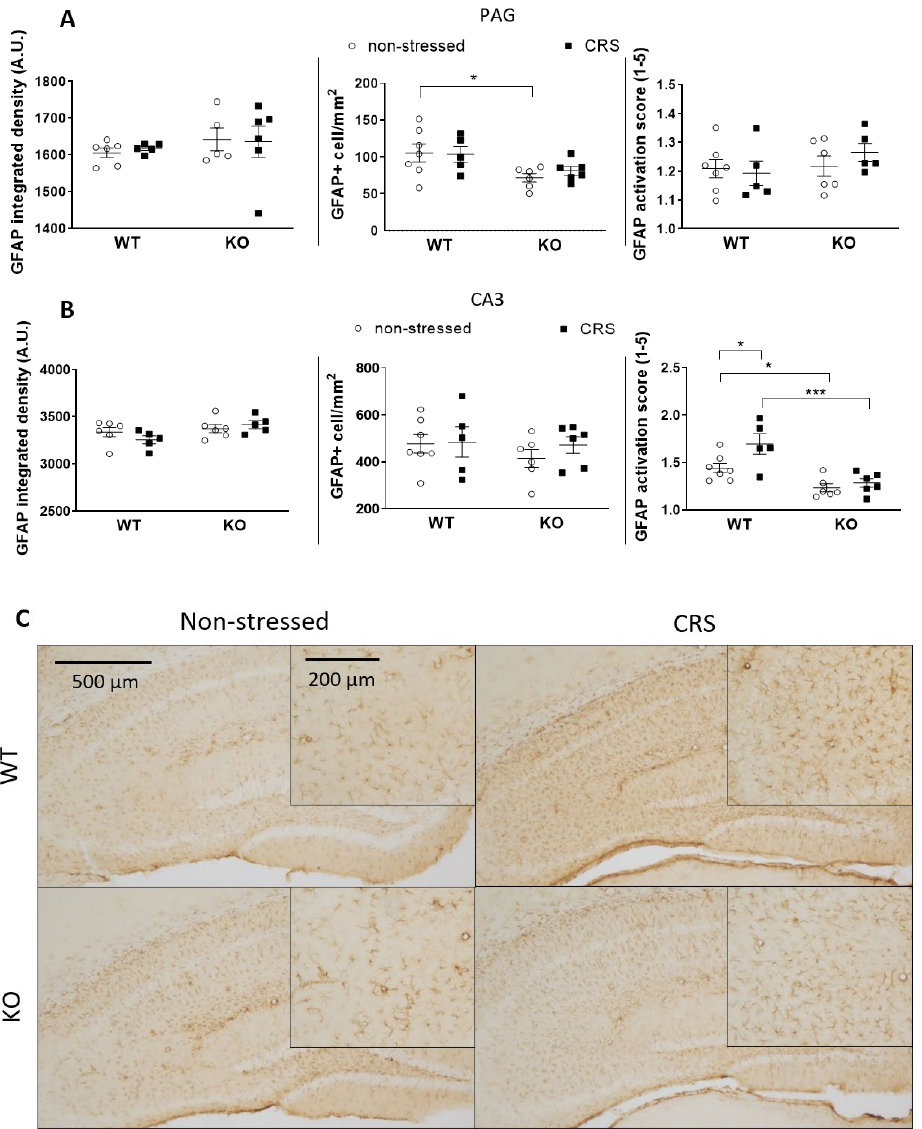
Figure 11. Diagrams show the Glial fibrillary acidic protein (GFAP) integrated density, the number of GFAP+ cells and the GFAP activation score of astrocytes examined in the periaqueductal gray matter (PAG—( A )) and the hippocampus cornu ammonis area 3 (CA3—( B )). Representative images show the GFAP+ astroglia cells in CA3 ( C ). Chronic restraint stress (CRS), Wild-type (WT), Interleukine-1 knock-out (KO). Data are presented as the means ± SEM of n = 5–7 animals with individual plots; two-way analysis of variance (ANOVA), followed by Tukey’s tests; * p < 0.05, *** p < 0.001 vs. respective